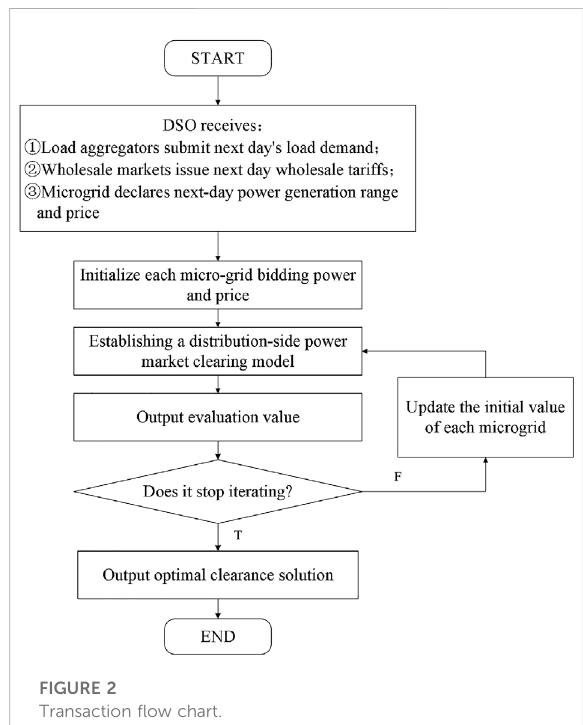
FIGURE 2 Transaction fl ow